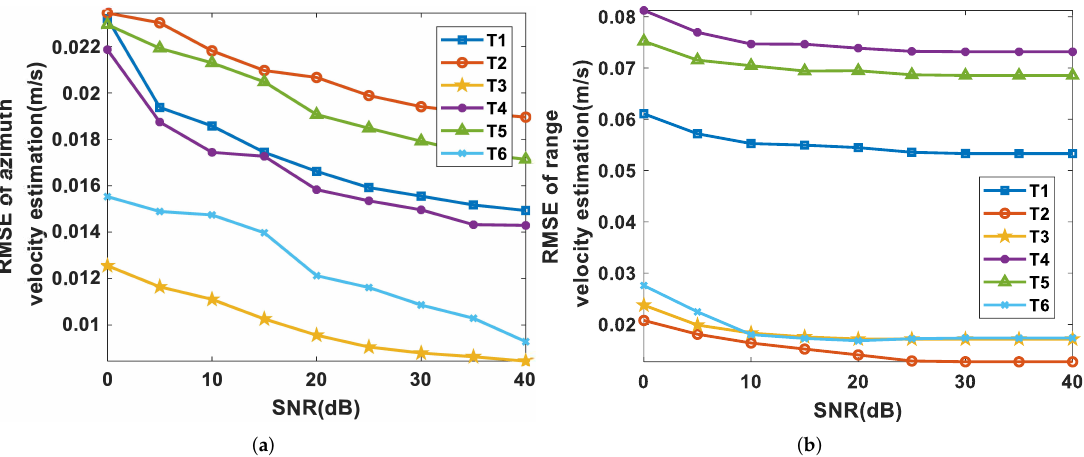
Figure 13. Performance analysis of 2D velocity estimation: ( a ) the RMS error of azimuth velocity estimation versus SNR; ( b ) the RMS error of range velocity estimation versus